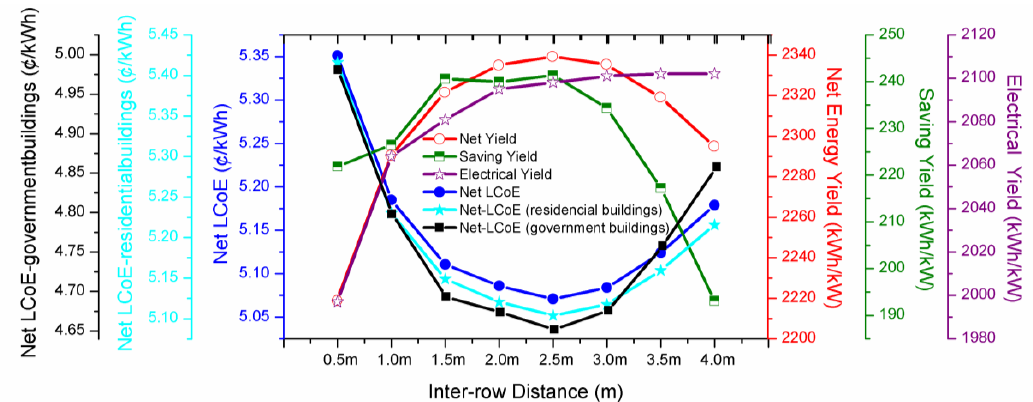
Figure 8. Energy yields and LCoE for rooftop PV configuration.